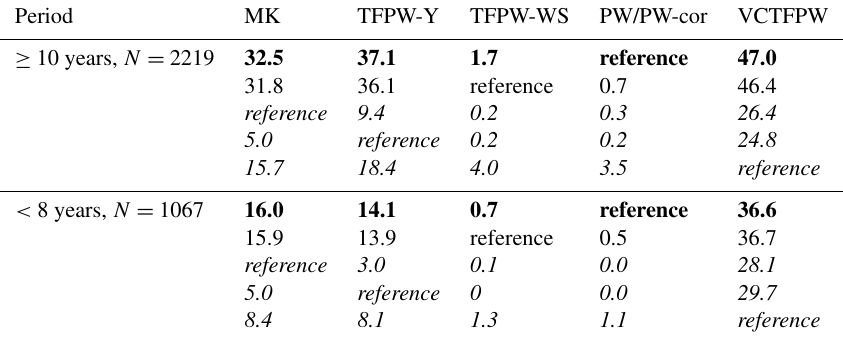
Table 3. Percent of false positives for all data sets relative to a reference test for the MK tests and prewhitening methods for periods of at least 10 years (decadal trends) or smaller than 8 years. N is the number of considered trends. PW should be considered the best reference so that the results are given in bold. MK, TFPW-Y and VCTFPW have a higher number of type 1 errors and should not be considered a reference so that these results are given in